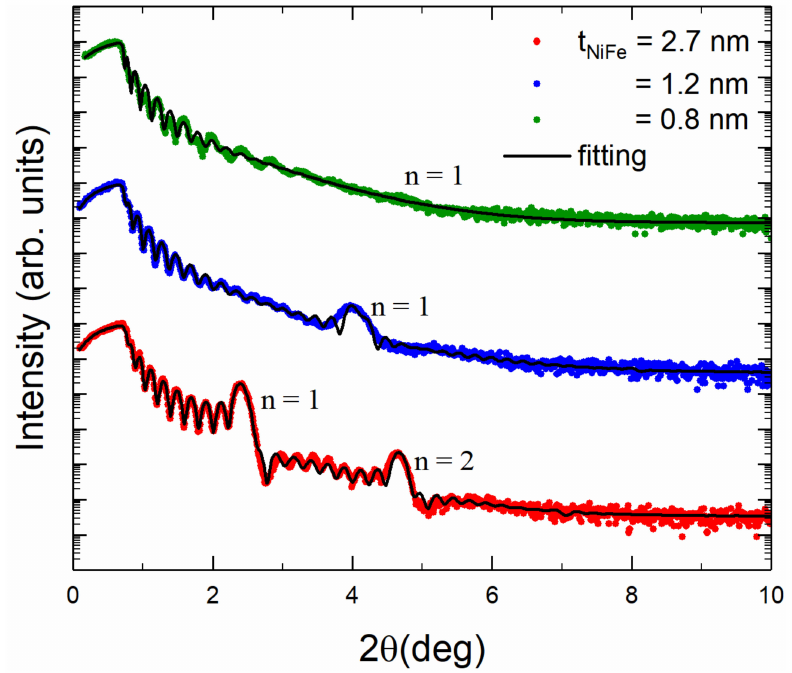
Figure 1. XRR patterns for three NiFe/NiFeO multilayers with 21 (green), 17 (blue) and 10 (red) repetitions (colored data points). All samples have a total thickness of about 40–50 nm. The fitted patterns using the GenX code are also shown as continuous lines). From the fitting, the t NiFeO was found to be 1.4 ± 0.2